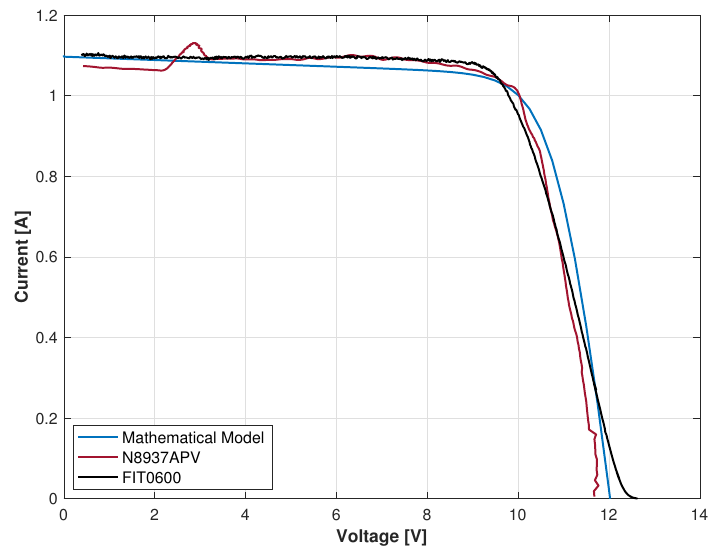
Figure 19. Current against voltage under STC profile comparison. Consequently, we clearly validated that the IV dynamics of the mathematical model and the N8937APV are reliable representations of the dynamic features of the real FIT0600 PV array. Still, to fully address the power signal dynamic features, Figure 20 compares the power vs. voltage curves obtained through the acquired data from Figure 19. Moreover, Figure 20 allows graphical validation of the representation of the real PV array, mostly since the slopes are dynamically consistent between them, and the achievable MPP still remains around 10 W.